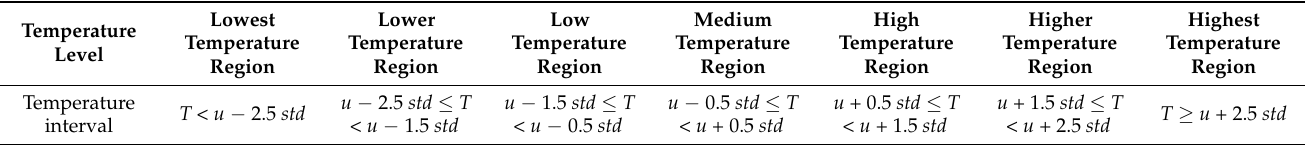
Table 3. Surface temperature class